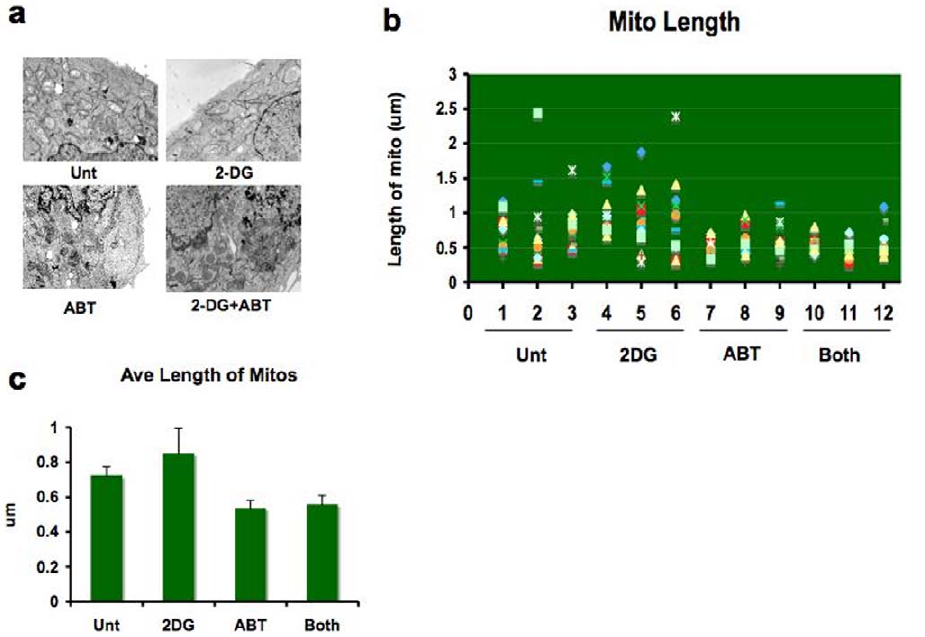
Figure 2. Combination of 2DG and ABT-263 does not cause mitochondrial outer membrane rupture. HeLa cells treated with either 10 mM 2DG for 6 hours, 1 m M ABT-263 for 3 hours, or 2DG for 3 hours before adding ABT-263 for an additional 3 hours, or left untreated. a, Cells were fixed for electron microscopy (see Method). Three cells from each treatment group were examined closely for the length of mitochondria. We did not observe a single instance of ruptured mitochondrial outermembranes. b, From each cell, a minimum of 12 mitochondria were randomly chosen for measurement. c, Average lengths of mitochondria became shorter with treatments containing ABT-263 (mean + / 2 std dev ). Since ABT- 263/737 binds to Bcl-2 family members, which are known to be involved in mitochondrial fusion/fission, ABT may have altered the balance of mitochondrial fusion/fission to the fission side (p=0.0001, 95% confidence interval of this difference: from 14.5407 to 37.2513; unpaired t-test).